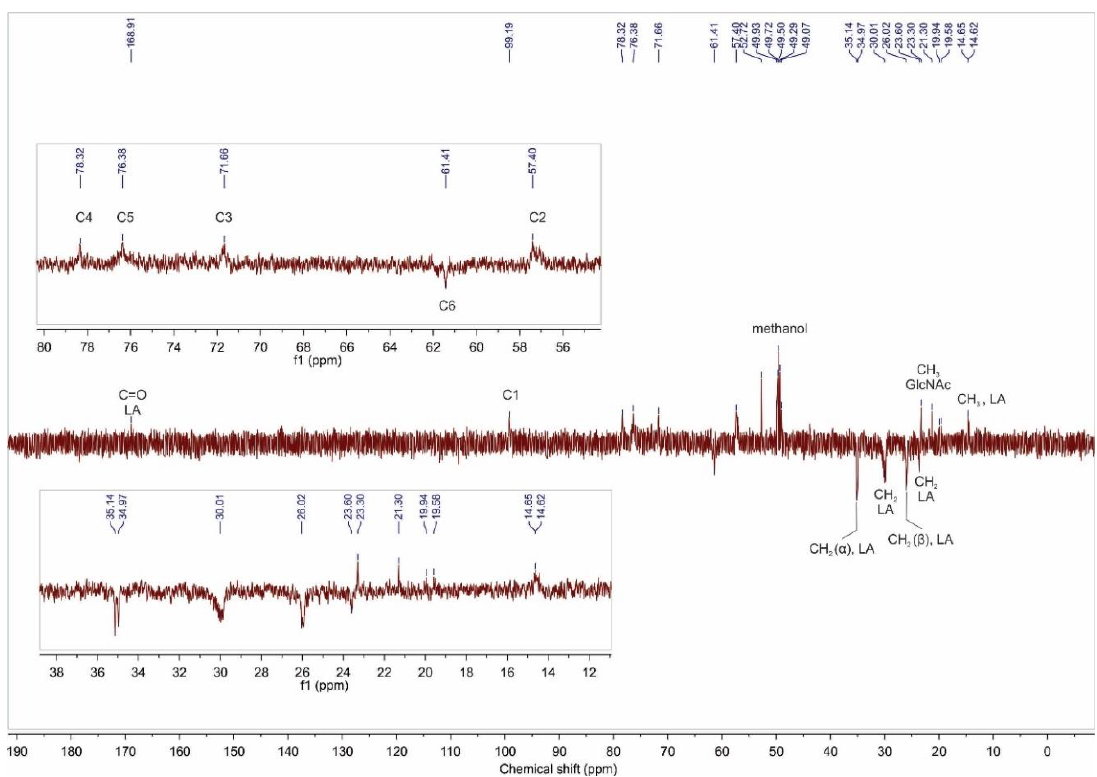
Figure 4. 13 C NMR DEPT-135 spectrum of the chitosan derivative 2a.